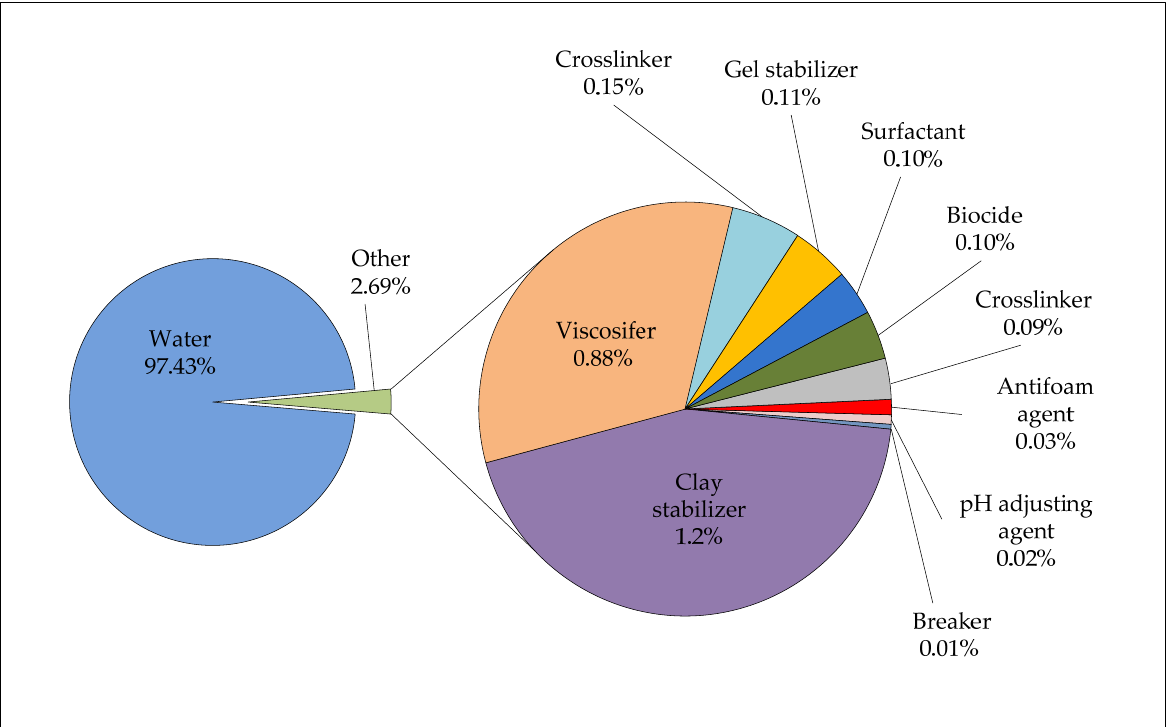
Figure 1. Example of the composition of water ‐ based fracturing fluid used in Croatia [3].